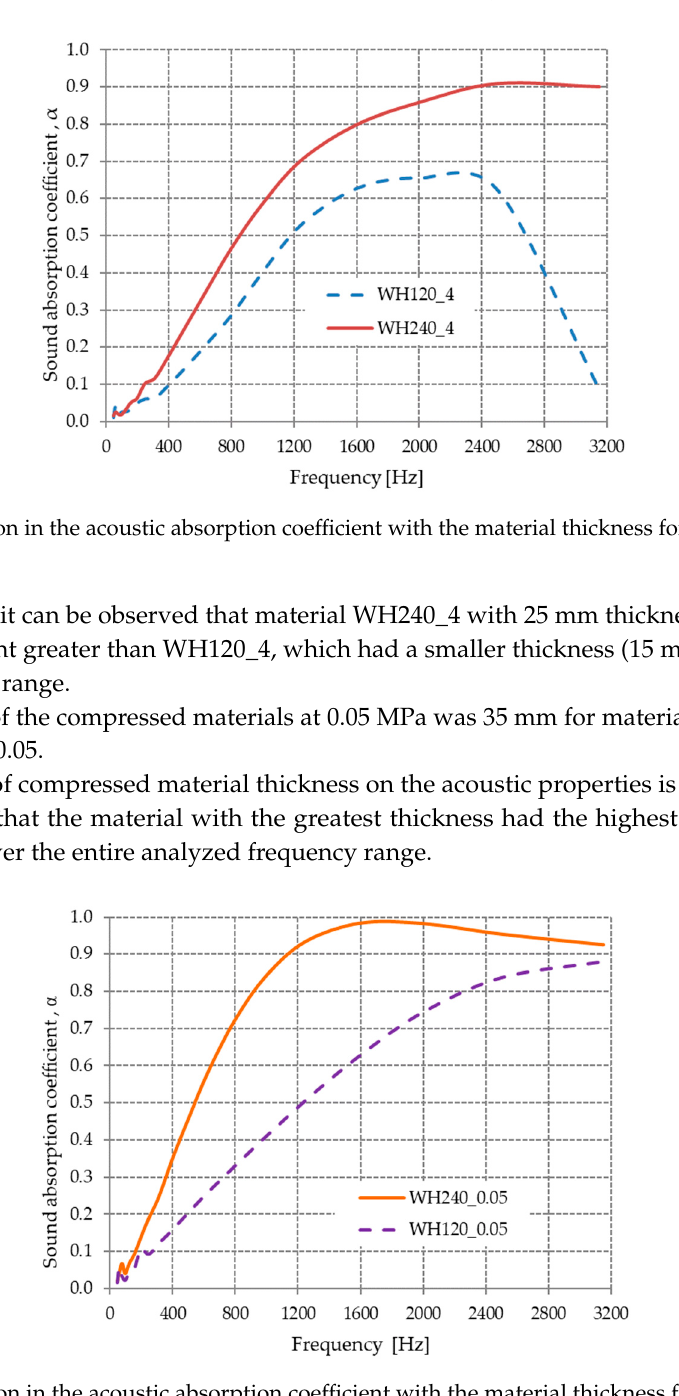
Figure 7. Variation in the acoustic absorption coefficient with the material thickness for WH120_0.05 and WH240_0.05.